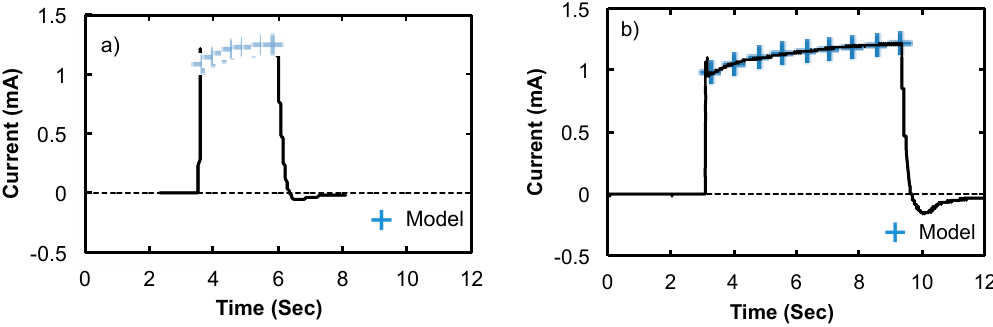
Figure 8. Plots of current vs. time during EPD of long m-SWCNTs for an isolated window ( a ) and a dense linear array ( b ).